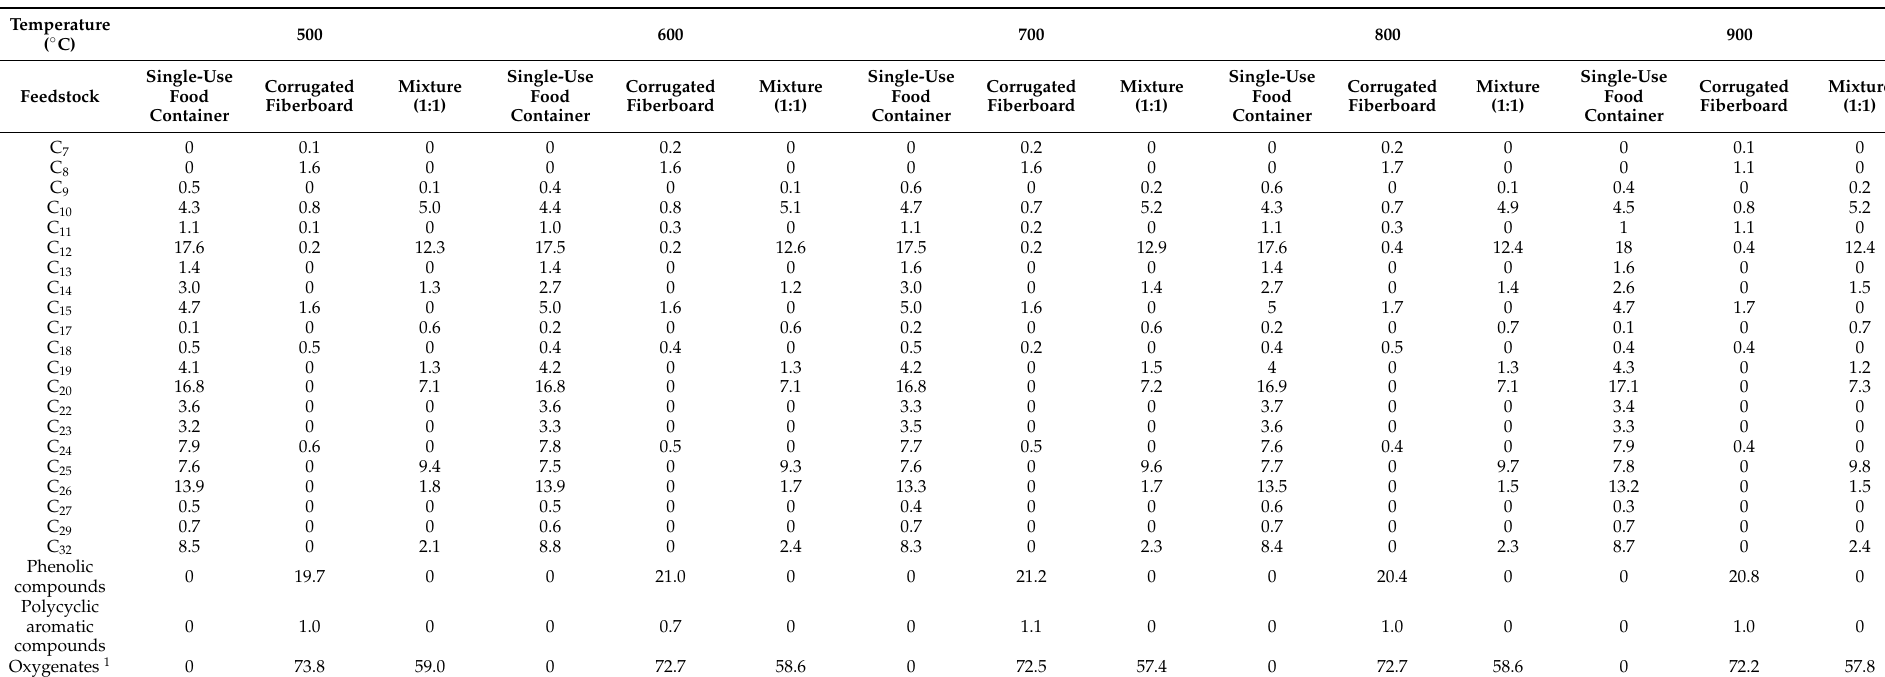
Table 3. Selectivity (%) toward each group of condensable compounds contained in the pyrolytic liquid (i.e., the mixture of condensable compounds) produced via the pyrolysis of single-use food containers, corrugated fiberboard, and a mixture of single-use food containers and corrugated fiberboard (1:1; mass basis) at different pyrolysis temperatures. Temperature ( ◦ C) 500 600 Single-Use Feedstock